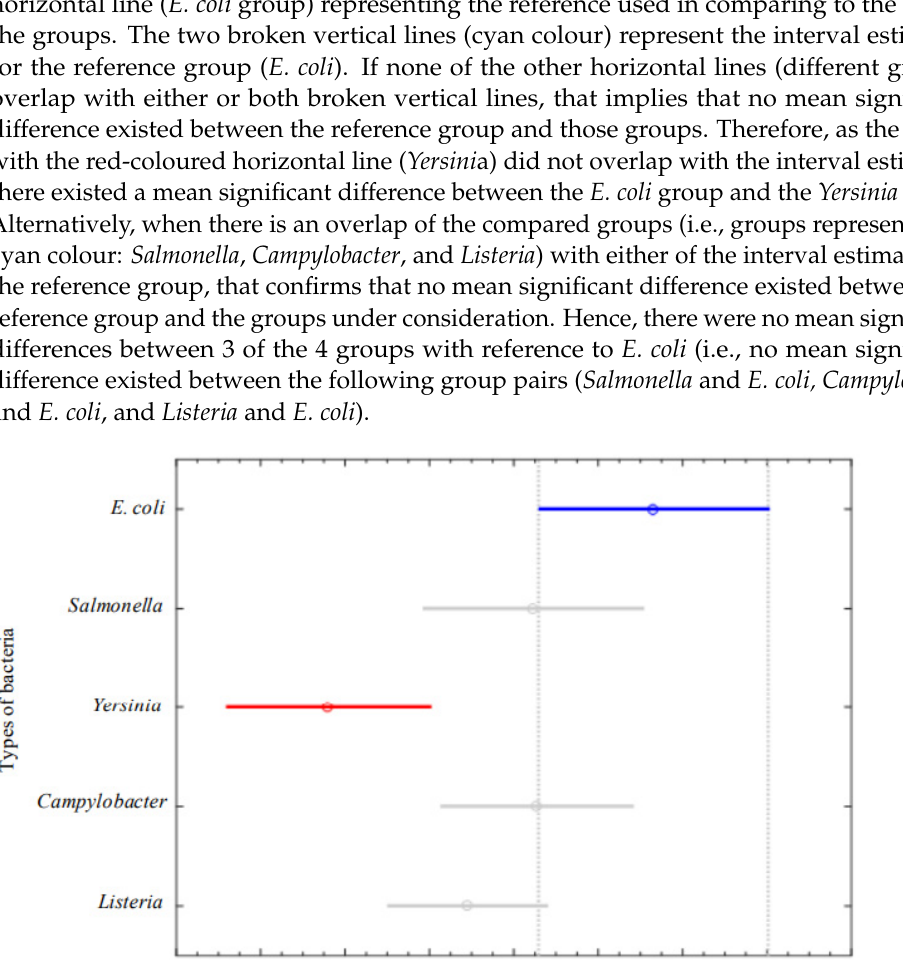
Table 2. Weight contribution of the predictors.